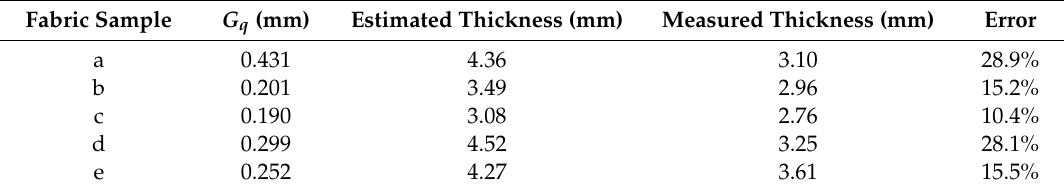
Table 1. Comparison results.